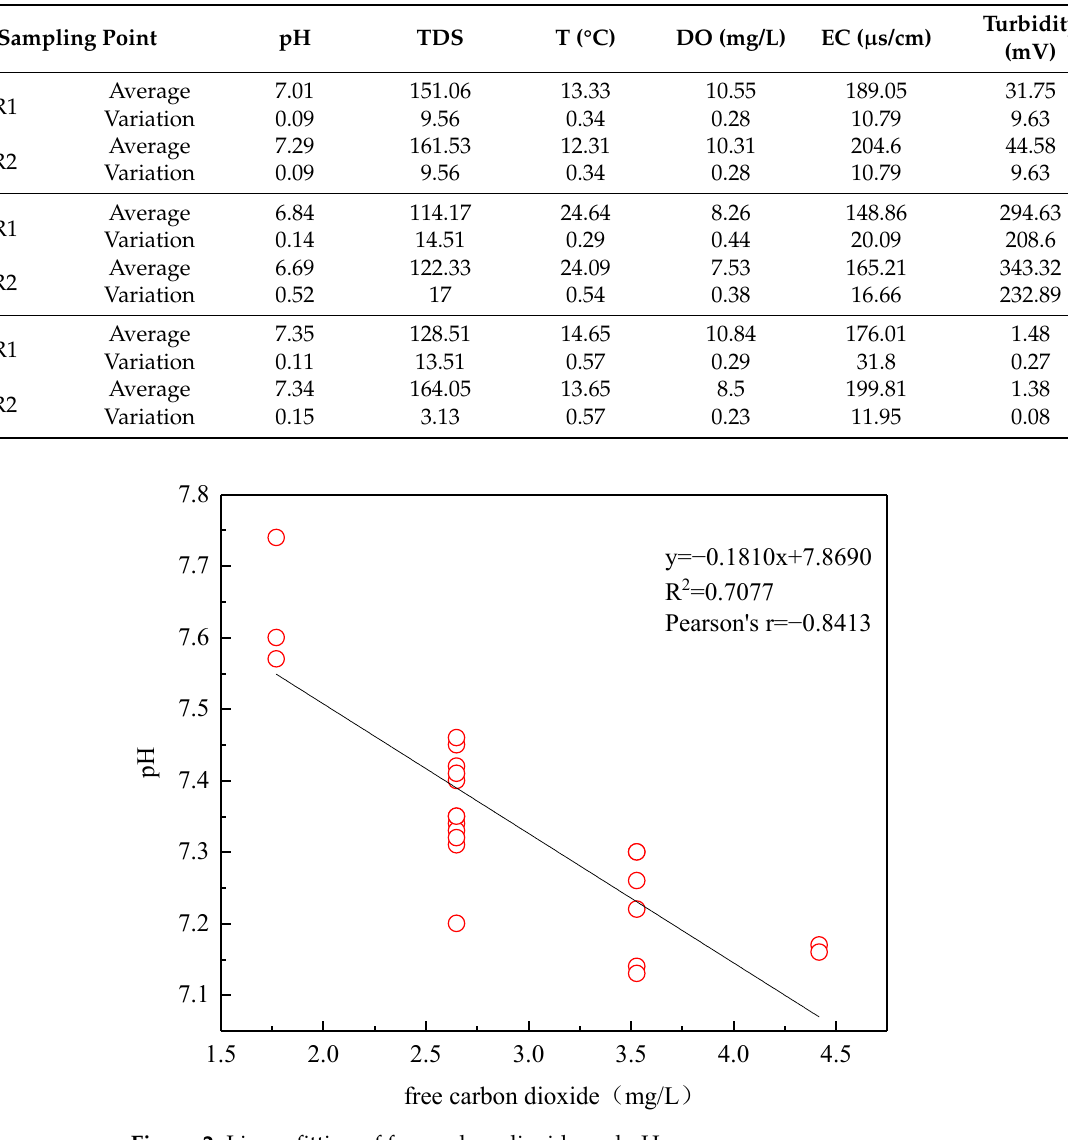
Table 2. Basic physical and chemical parameters of the Liujiang water body.